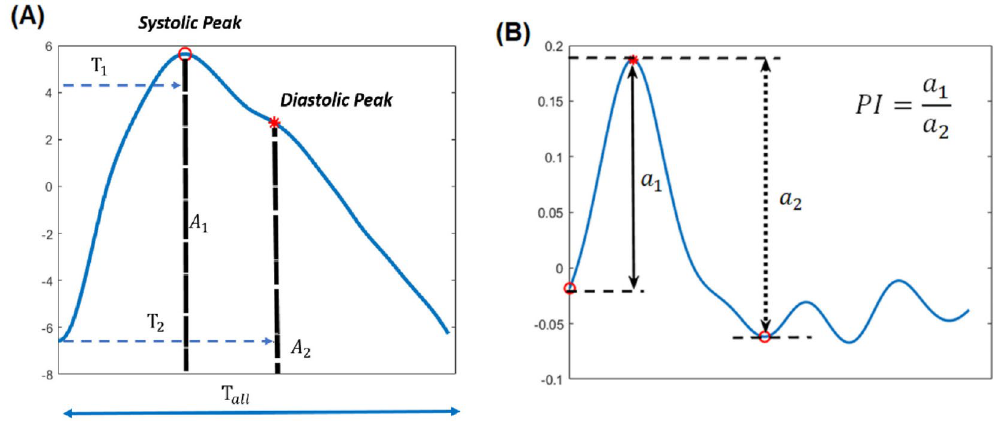
Figure 4. The calculation formula of reflection time index (RTI), augmentation index (AI), and perfusion index (PI). A: Template PPG waveform interpretation, A1 amplitude of systolic peak, A2 amplitude of diastolic peak, T1 time to reach the systolic peak, and T2 time to reach the diastolic peak B: Second derivative waveform transformed by the first-order differential of the template waveform for calculating